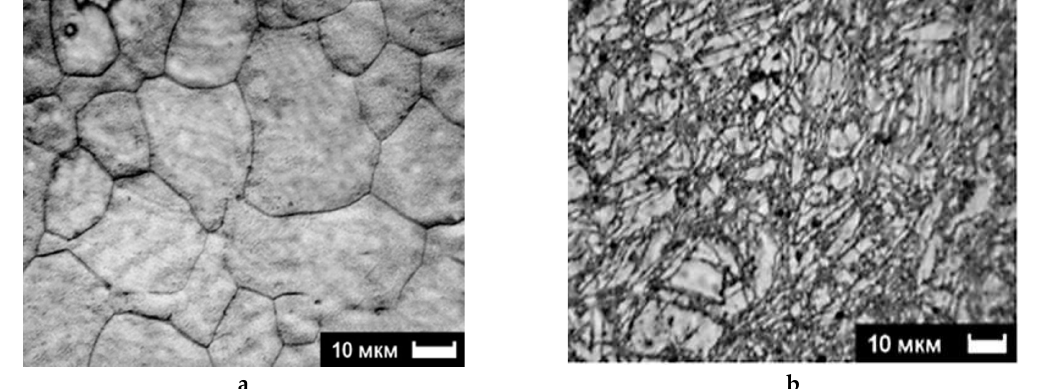
Figure 8. AZ31 microstructure: a —initial state, b —after 2 B C passes at 200 °C.